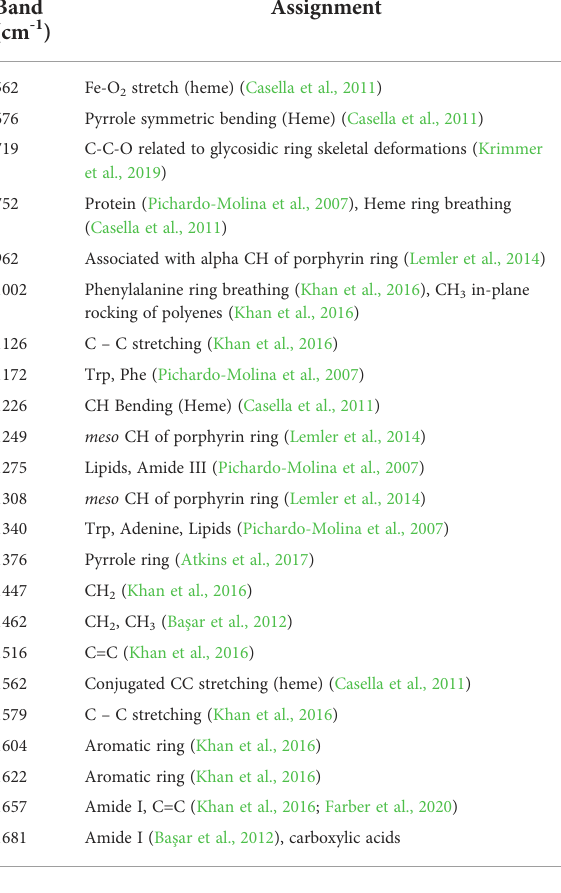
TABLE 2 Assignments of vibrational bands for the Raman spectra acquired from blood samples of Borreliella -infected C3H mice. Band (cm -1 )